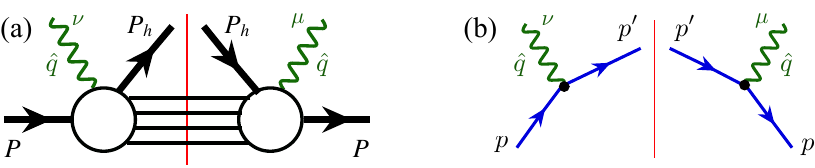
Figure 15 . Illustration of (a) the semi-inclusive hadronic tensor, f W µν (ˆ q, P, P h , S ) , and (b) the lowest-order contribution to f W µν (ˆ q, P, P h , S )